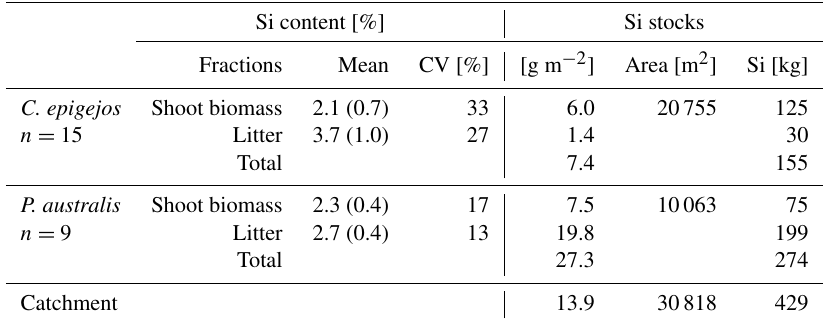
Figure 7. Correlation between fresh and dry green shoot biomass (a) and the respective biomass including litter (b) for C. epigejos and P. australis . Table 4. Mean Si content of biomass fractions of C. epigejos and P. australis and respective Si stocks calculated from the areal coverage derived from ML